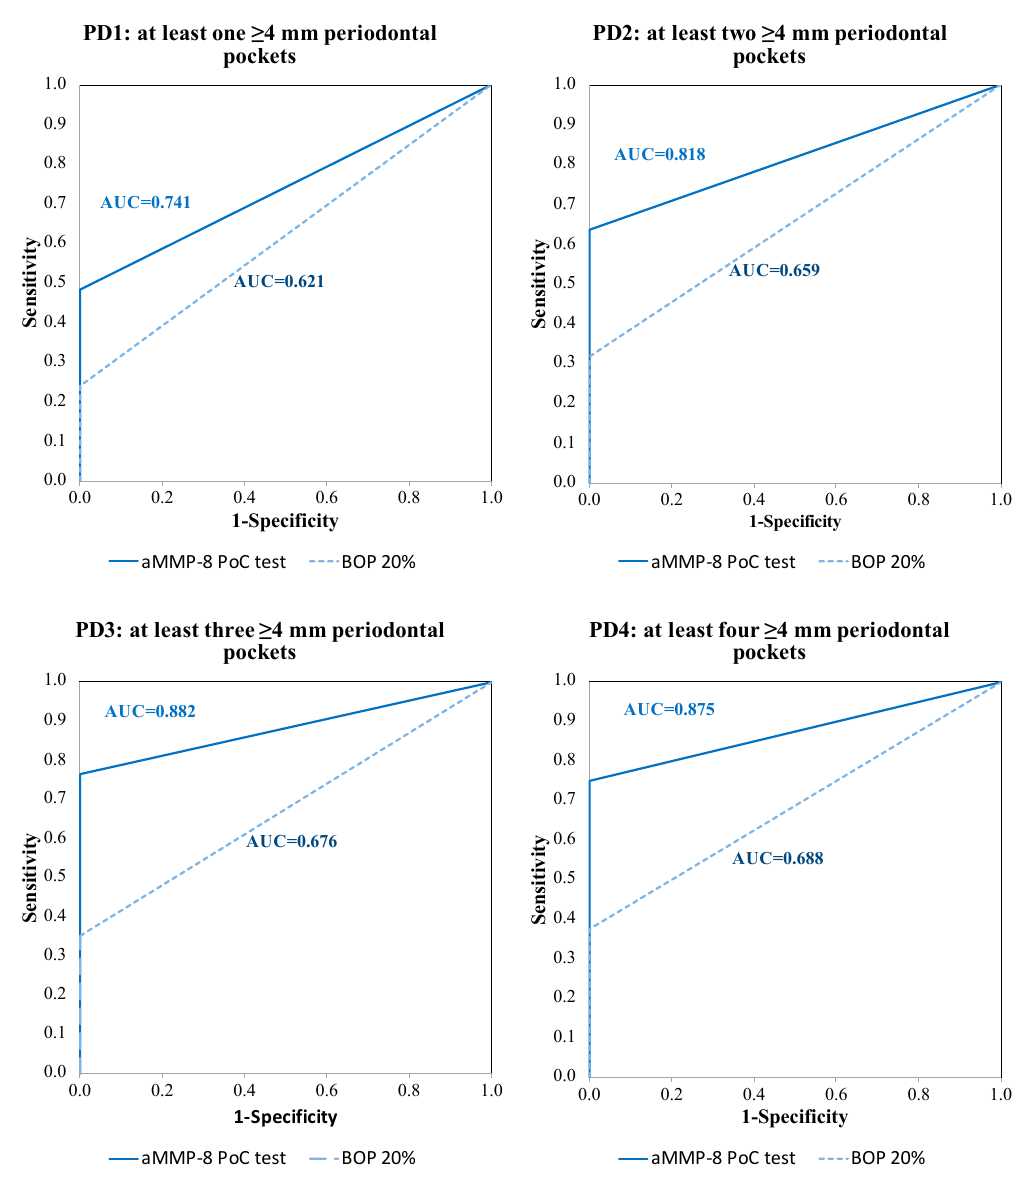
Figure 1. Receiver operating characteristic (ROC) curves and the area under the ROC curve (AUC) values for the aMMP-8 PoC test and the conventional BOP test (cutoff point 20% for positives) representing the ability of both tests to classify adolescents with and without initial periodontitis or subclinical periodontitis (PD1–PD4).